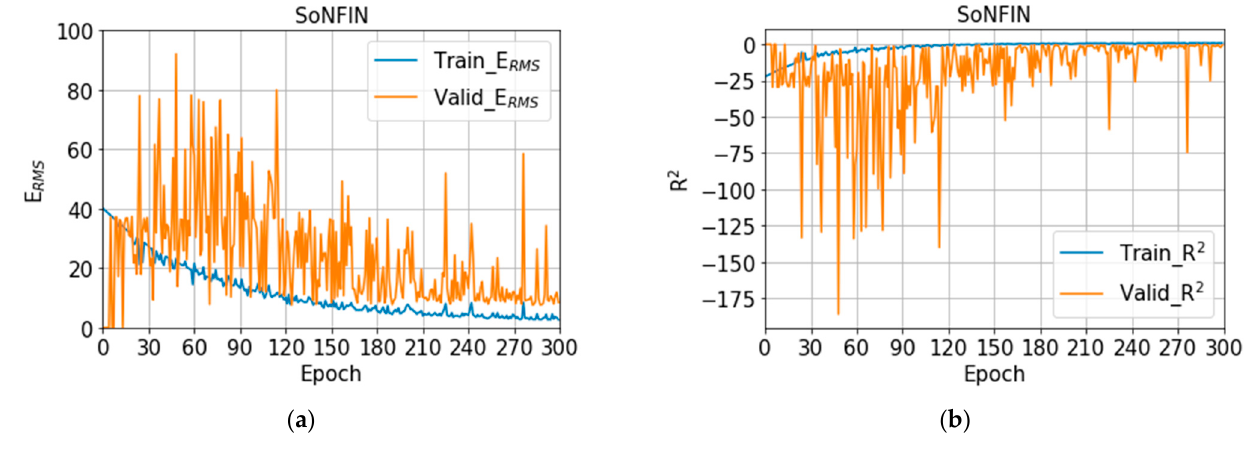
Figure 9. ( a ) The training (blue) and validation (orange) curves of E RMS , ( b ) the training (blue) and validation (orange) curves of R 2 with SoNFIN.